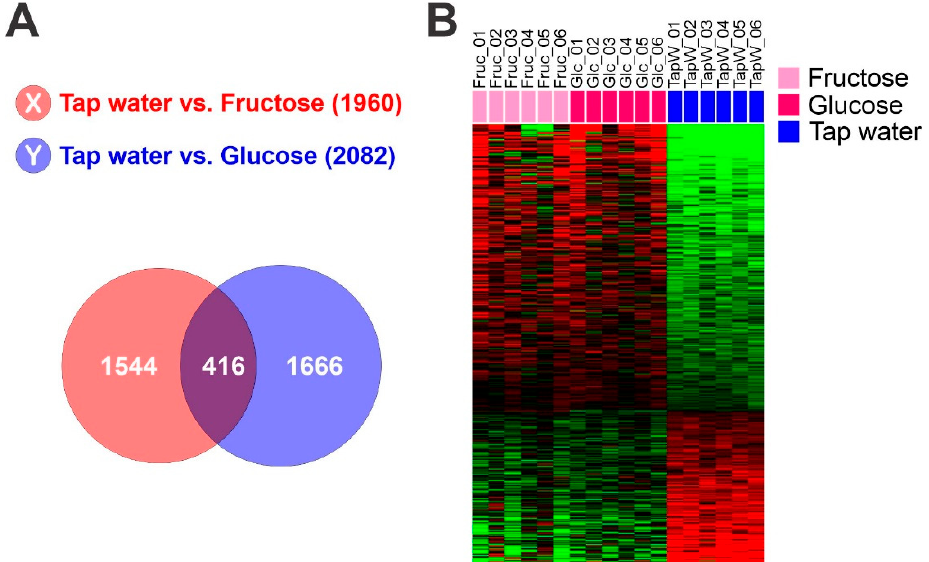
Figure 1. Hepatic glycolytic gene expression signature from mouse liver. ( A ) Venn diagram of genes selected by a two-sample t test. The red circle (gene list X) represents genes differentially expressed between liver tissues from mice fed with tap water and those fed with fructose water. The blue circle (gene list Y) represents genes differentially expressed between liver tissues of mice fed with tap water and those fed with glucose water. We applied a cut-off p -value of less than 0.01 to retain genes whose expression is significantly different between the two groups of tissues. ( B ) Expression patterns of selected genes in the Venn diagram. Gene expression data from livers of mice fed with fructose, glucose or control tap water were selected from 416 overlapping genes.